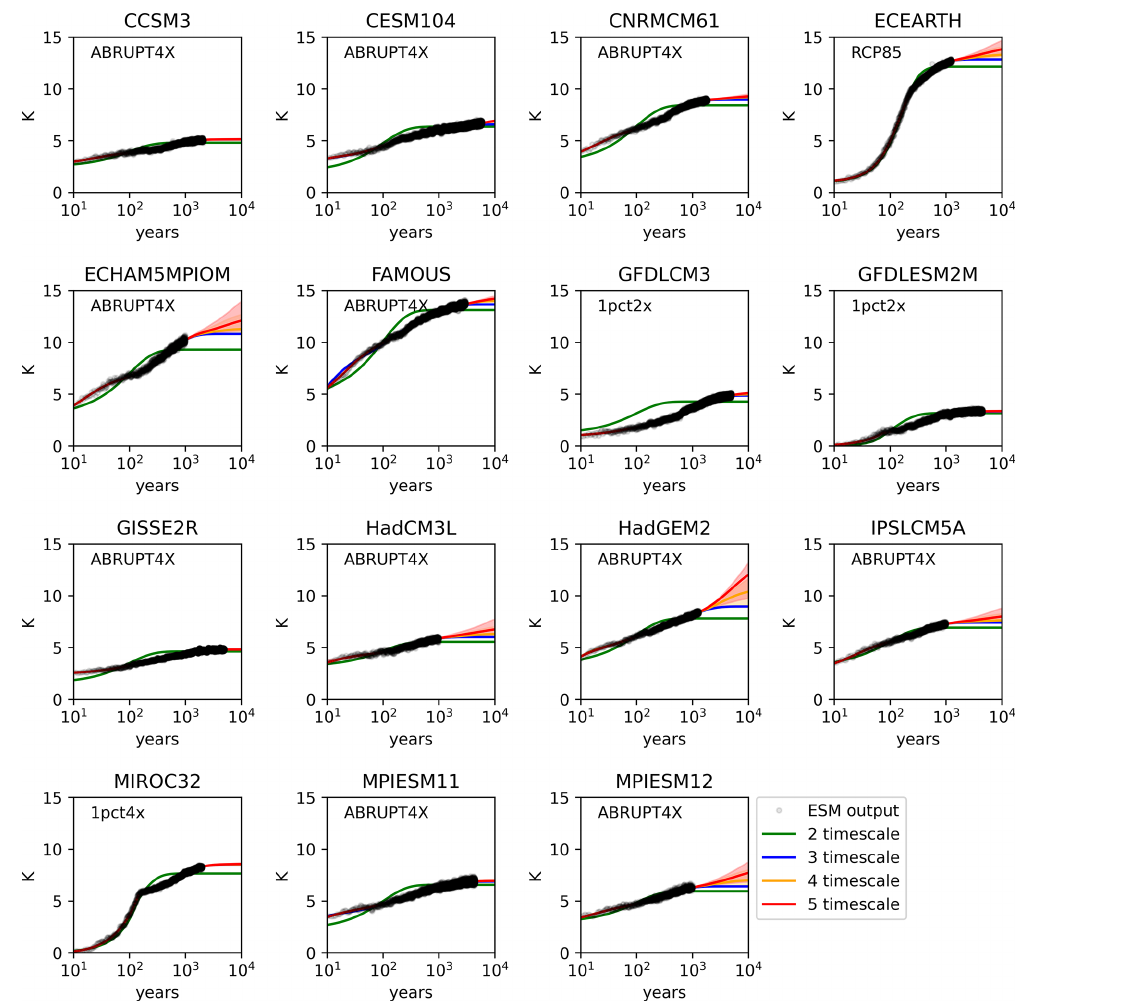
Figure A1. Results fitting multi-timescale models to output of LongRunMIP multi-thousand-year experiments for global mean surface temperature. Different colors represent different models as detailed in Table 1; shaded areas indicate the 5th–95th percentile range in the MCMC fit to the time series. Text indicates the model scenario used in the fit (as detailed in Table 3).